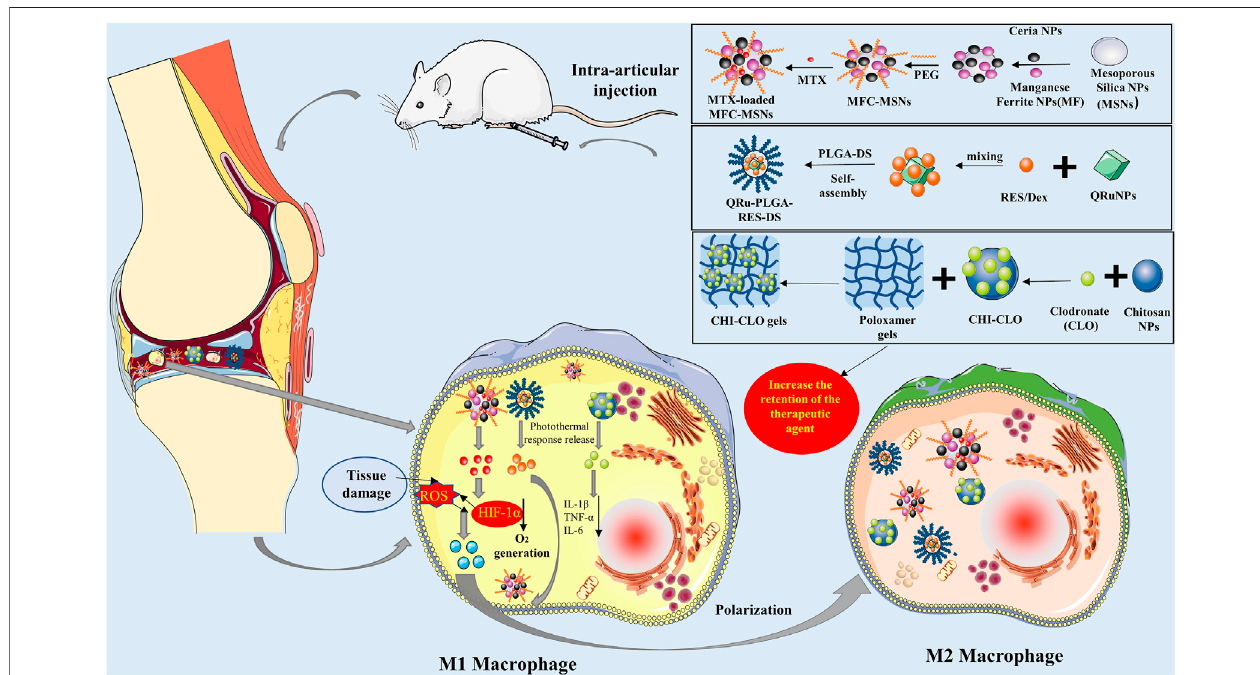
FIGURE 4 | Preparation and application of MTX-loaded MFC-MSN nanoparticles (NPs), QRu-PLGA-RES-DS NPs, CHI-CLO gels, and intra-articular injection of NPs into an RA model mouse. (1) MFC-MSNs synergistically scavenge ROS and produce O 2 , leading to the polarization of pro-in fl ammatory M1 macrophages to the anti-in fl ammatory M2 phenotype in hypoxic and in fl amed synovial joints. (2) As photothermal agents, the Ru NPs control the precise release of the RES through the photothermal effect and achieve high-ef fi ciency polarization of M2 type macrophages for treating RA. (3) CHI-CLO NPs were added into the poloxamer gel matrix for intra-articular administration, which increased CLO retention in the joint, improved the therapeutic effect, reduced the side effects, and inhibited the release of IL-1 β , TNF- α ,andIL-6inmacrophages. CHI-CLO, chitosan-clodronate;IL-1 β ,interleukin-1 β ;IL-6,interleukin-6;MTX,methotrexate;MFC-MSNs, manganese ferriteandceria nanoparticle – anchored mesoporous silica nanoparticles; PEG, poly (ethylene glycol); QRu-PLGA-RES-DS, quadrilateral ruthenium-poly (lactic-co-glycolic acid)- resveratrol-dextran sulfate; RA, rheumatoid arthritis; ROS, reactive oxygen species; Ru, ruthenium; TNF- α , tumor necrosis factor α